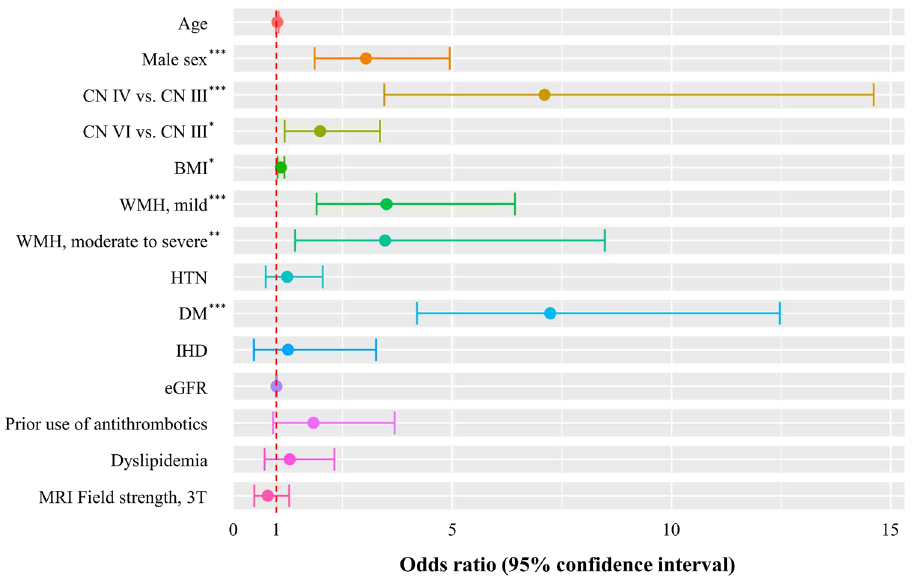
Figure 2. Forest plots for odds ratios of the ocular cranial nerve palsy of presumed ischemic origin (OCNPi) compared with ocular cranial nerve palsy of other origin (OCNPo) based on multivariate logistic regression analysis. CN cranial nerve, BMI body mass index, WMH white matter hyperintensities, HTN hypertension, DM diabetes, IHD ischemic heart disease, eGFR estimated glomerular filtration rate. *** P < 0.001; ** P < 0.01; * P <